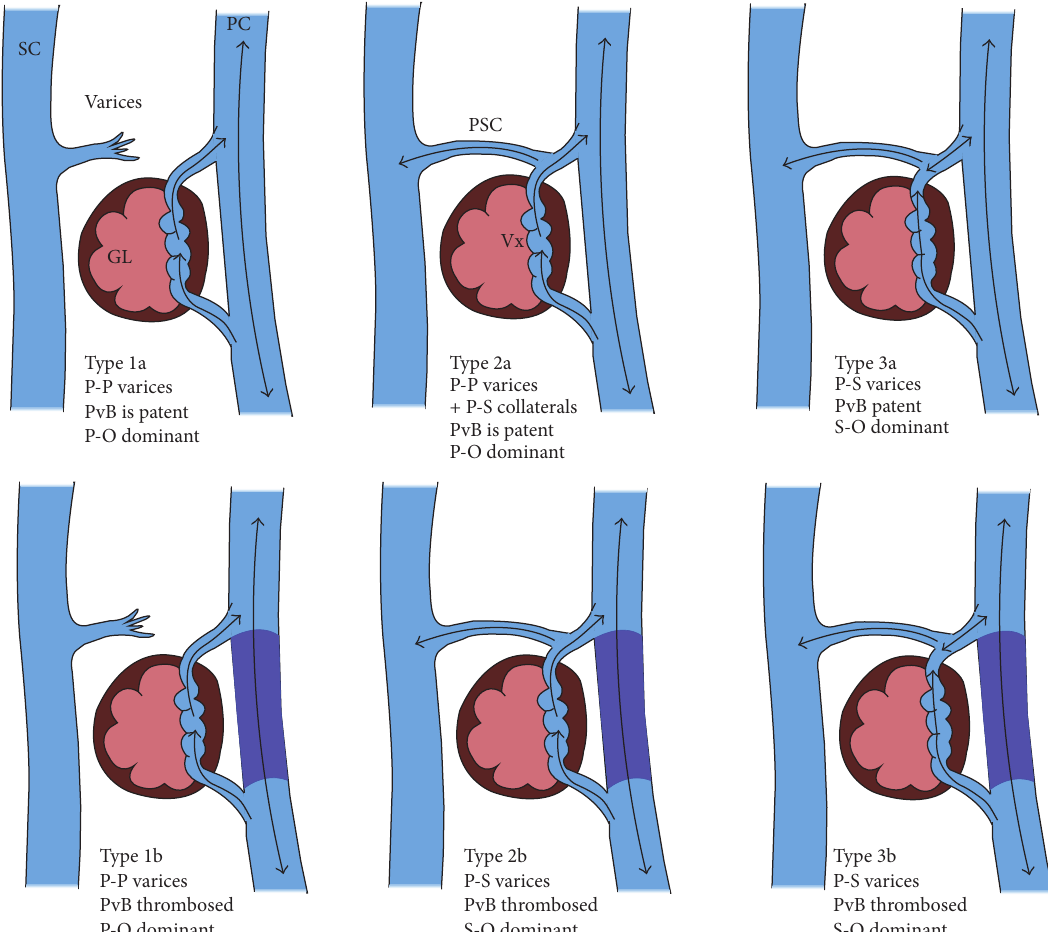
Figure 5: Classification of ectopic varices. SC: systemic circulation; PC: portal circulation; P-P: portoportal collaterals, P-S: portosystemic collaterals; PvB: portal venous branch; P-O: portal outflow; S-O: systemic outflow. Modified and redrawn from